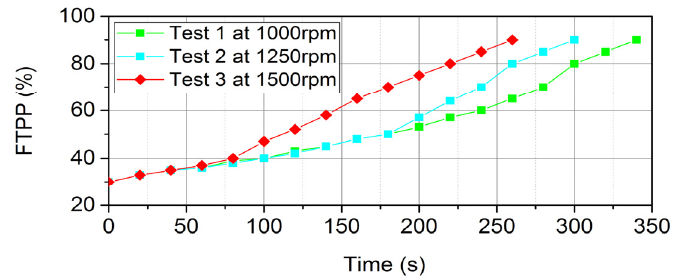
Figure 5. Transient tests carried out to analyse NOx